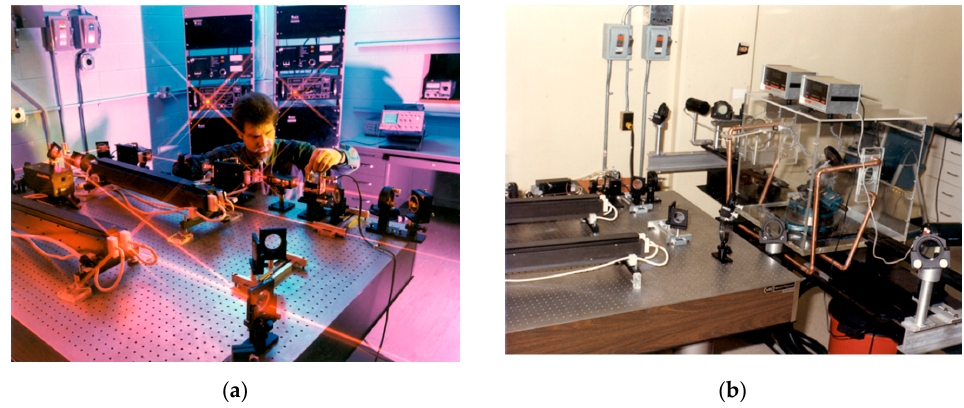
Figure 17. Laser designed and built at Battelle to demonstrate the ability to build the small, high energy pulsed lasers necessary to commercialize laser shock peening; ( a ) laser; ( b ) work cell.